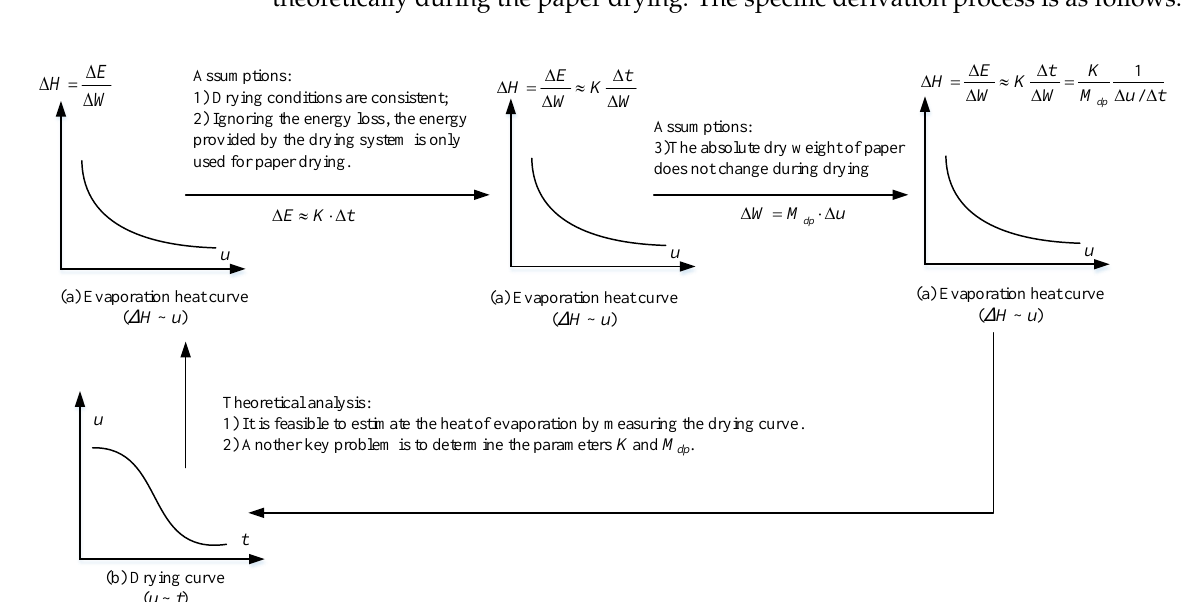
Figure 1. Schematic diagram of evaporation heat measurement based drying curve: ( a ) Evaporation heat curve; ( b ) Dry- ing curve.